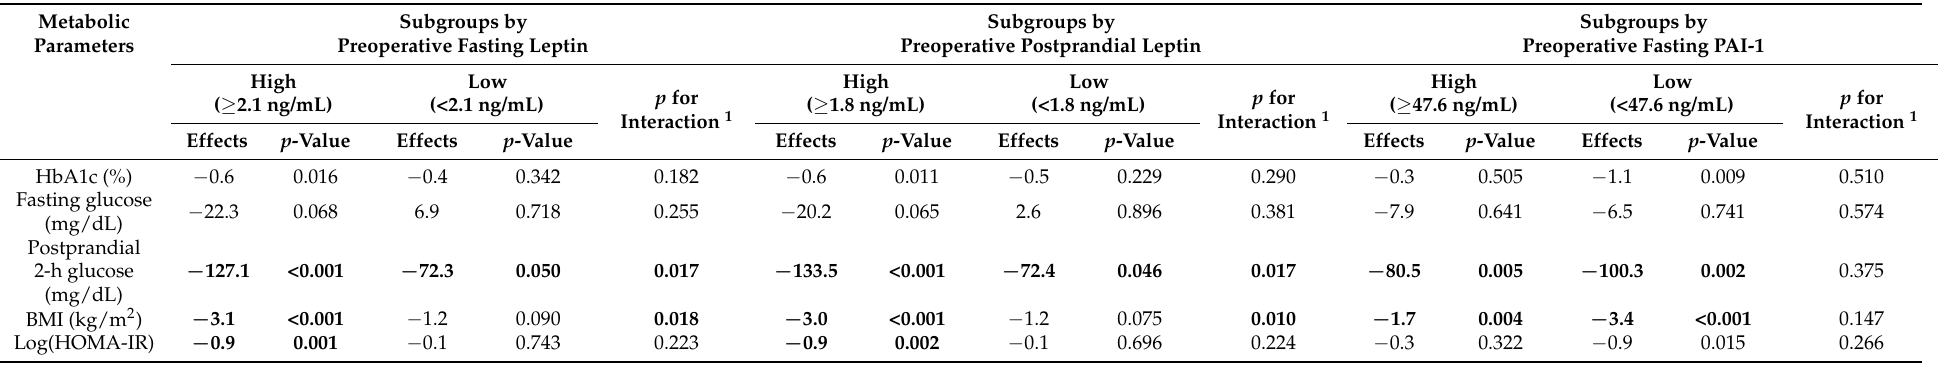
Table 4. Changes in the metabolic parameters after gastrectomy with duodenal bypass compared with ESD as a reference in the subgroups classified by preoperative fasting leptin, postprandial leptin, and fasting PAI-1